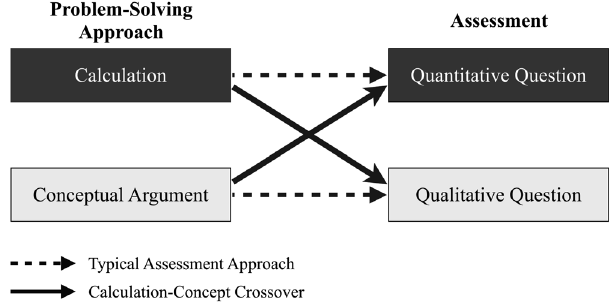
FIG. 1. Though typical assessment approaches link calculations to quantitative questions and conceptual arguments to qualitative questions, a paradigm for assessing mathematical sense making can search for calculation-concept